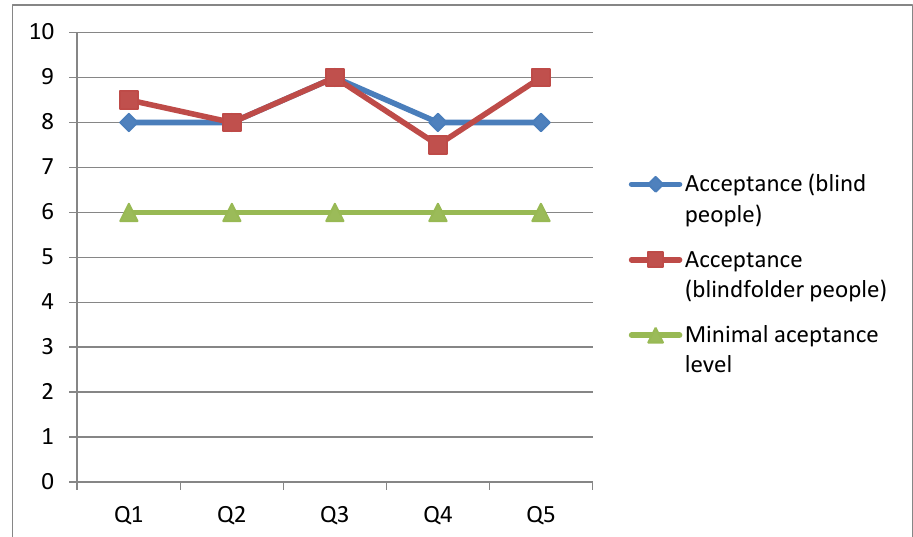
Figure 14. Median of the experimental results for blind and blindfolded